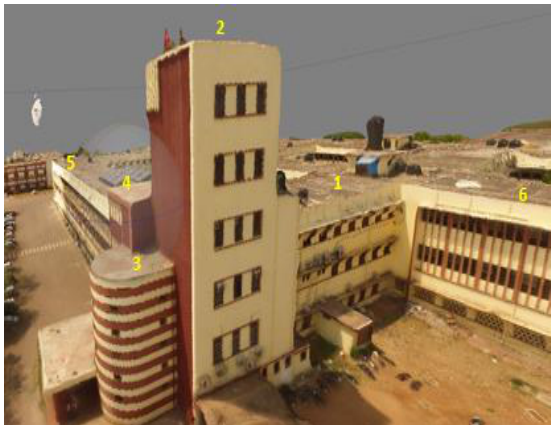
Figure.7. 3D model with sample points for elevation